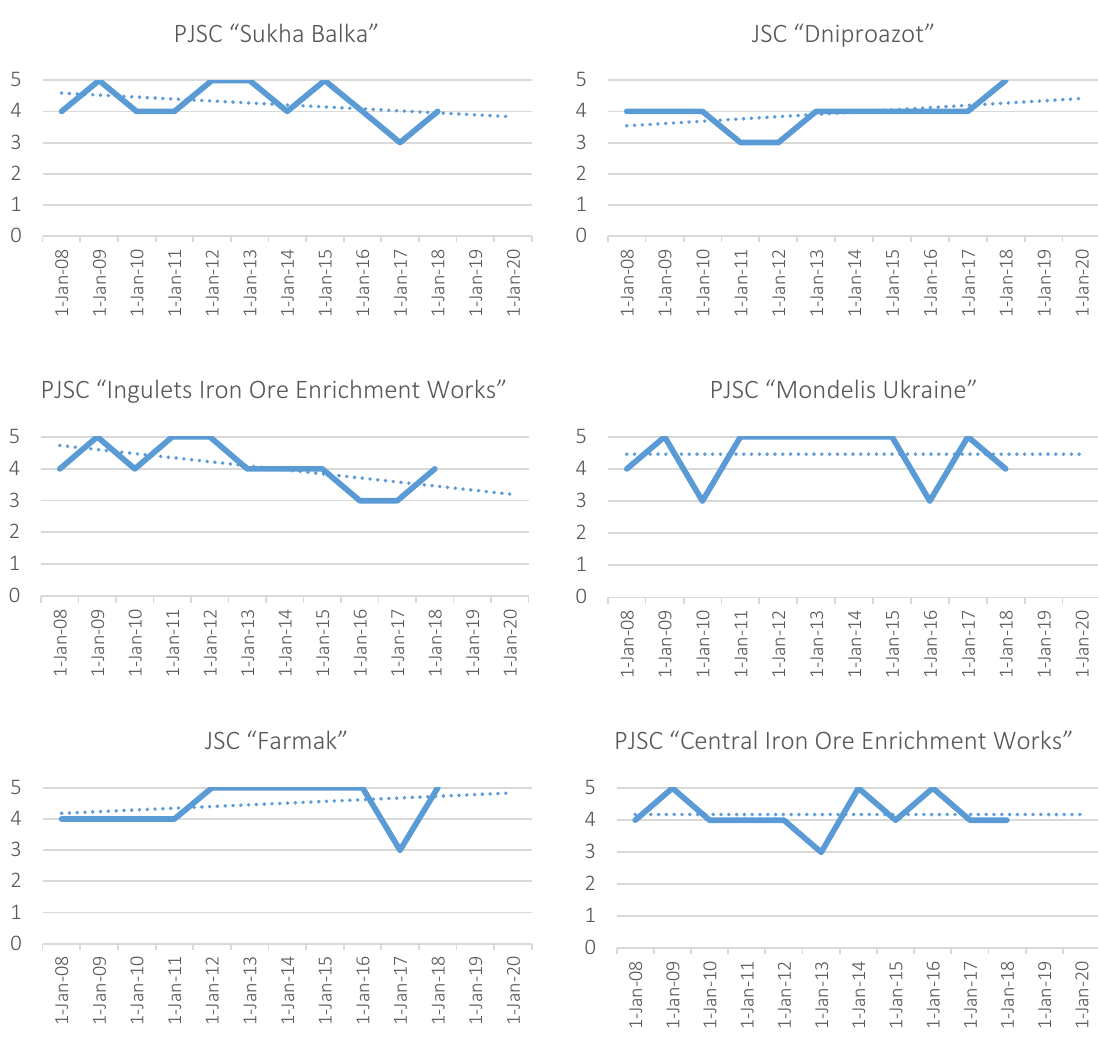
Figure 4. Group of conditionally stable Ukrainian companies (within the relevant